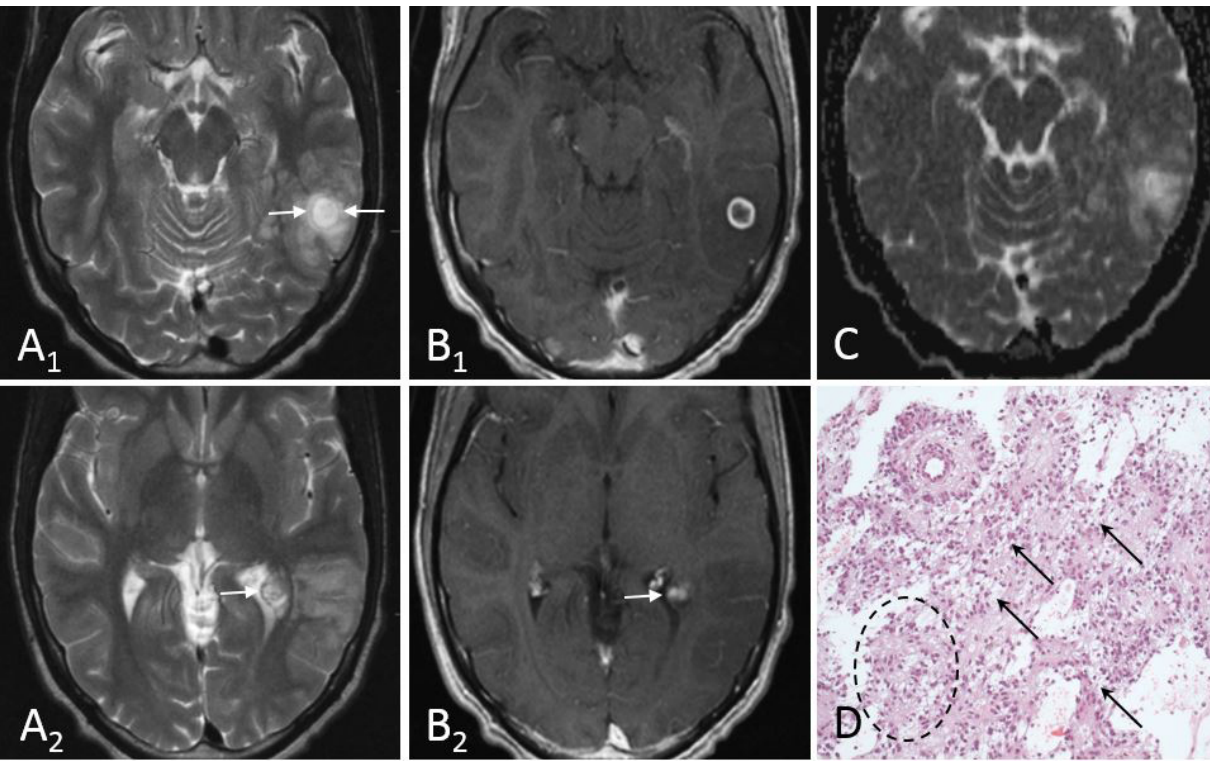
Fig. 5. Case 5. A case of multifocal and morphologically multifaceted aPA presentation. Axial T2-weighted image (A1) shows a cystic-like lesion with mild vasogenic edema in the left temporal lobe subcortical white matter (arrows), with a thin, T2-hypointense and intensely enhancing rim on T1-weighted post- gadolinium images (B1). More caudally, (A2) shows a subependimal nodule abutting in the left ventricular atrium (arrow), with minimal vasogenic edema, and subtle core enhancement (arrow in B2). ADC map (C) demonstrates increased water diffusivity. Microscopically (D) this tumor exhibits a loose pattern with regular, round cells, with remarkable microcystic, pseudo-oligodendroglial changes (dashed circle), sometimes forming pseudorosette-like structures, with granular eosinophilic bodies (arrows) and rare mitoses. Ki-67 expression was approximately